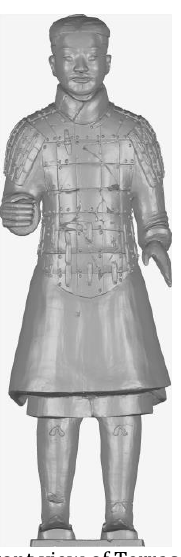
Figure 3 Front view of Terracotta